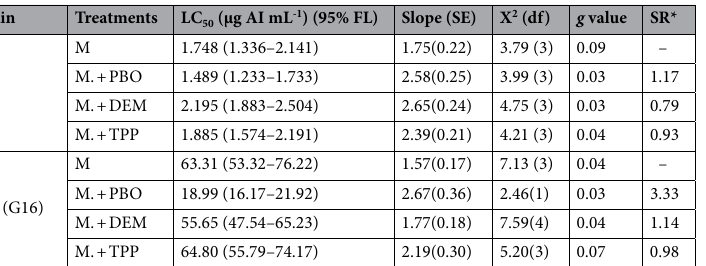
Table 1. Synergism of PBO, DEM, and TPP on methoxyfenozide in the 2nd instar larvae of susceptible (SUS.) and methoxyfenozide selected (MS) strains of Spodoptera littoralis after 96 h. post-treatment. M Methoxyfenozide, PBO Piperonyl Butoxide, DEM Diethyl Maleate, and TPP Triphenyl Phosphate. LC 50 is the concentration, in μg (microgram) of methoxyfenozide per mL (milliliter) of water, that is required to kill 50% of the tested population. X 2 chi-square, and df Degree of freedom. g value goodness of fit, and *SR (synergism ratio) = LC 50 without synergist/LC 50 with